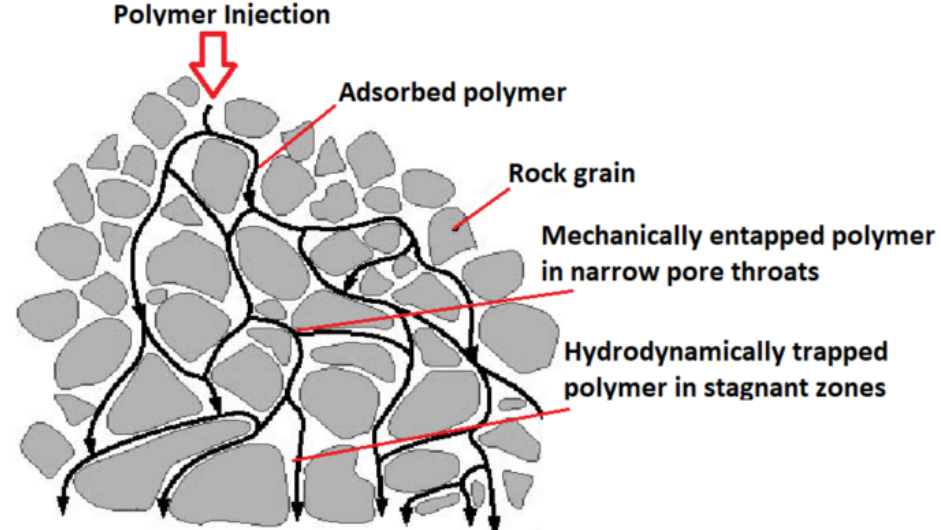
Figure 7. Several polymer retention mechanisms during polymer